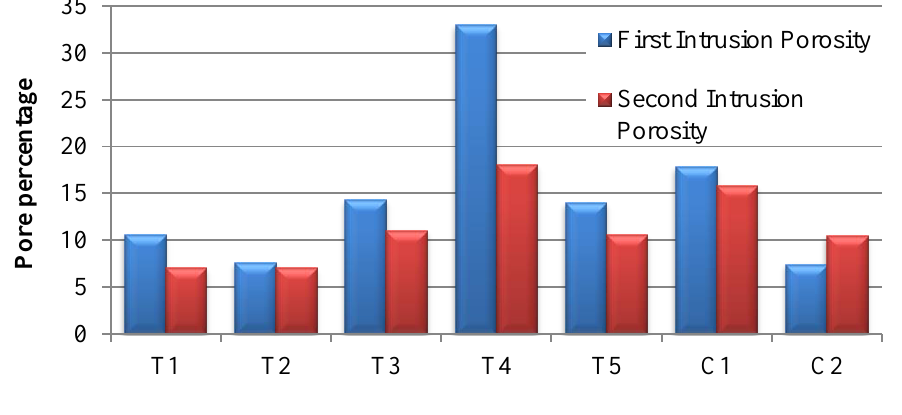
Figure 3. Coating porosity by MIP technique.